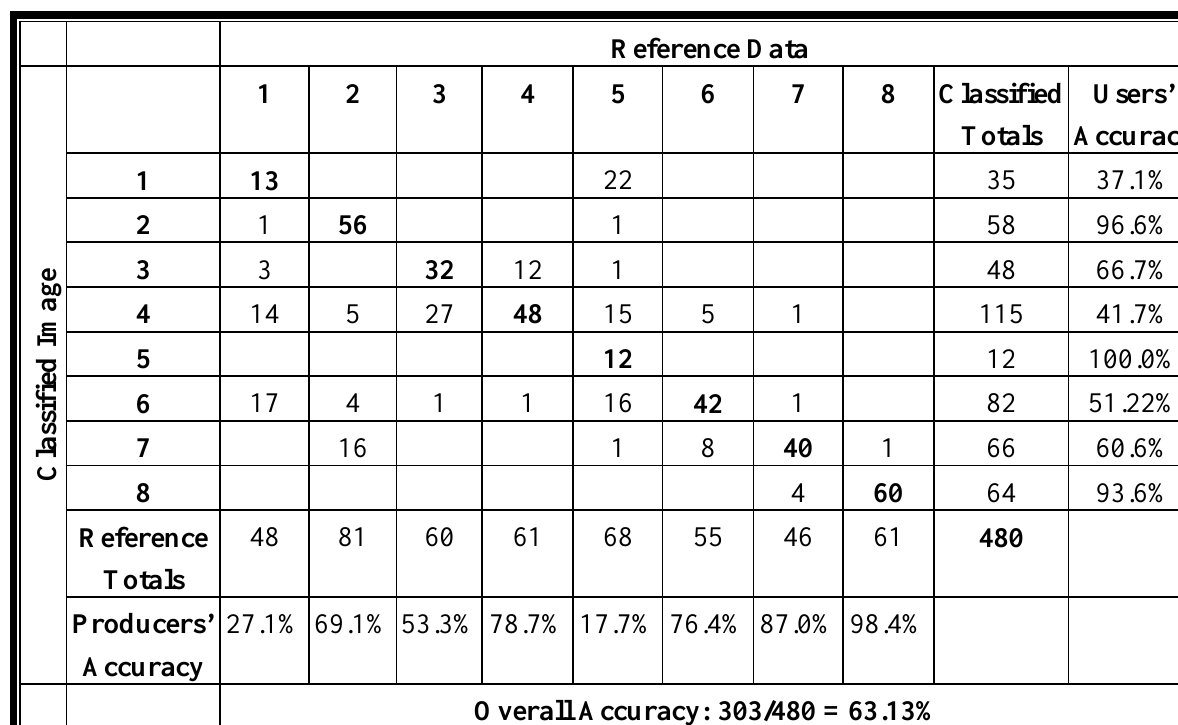
Table 4. Error matrix on the classified map from the